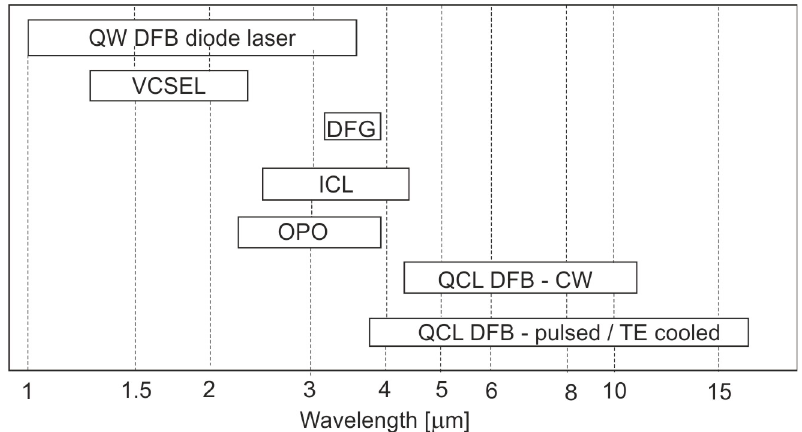
Figure 6. Spectral ranges of radiation sources are used in IR absorption spectroscopy. CW—continuous wave, QW DFB—quantum well distributed feedback, DFG—difference frequency generation, ICL—interband cascade laser, OPO—optical parametric oscillator, and QCL—quantum cascade laser.